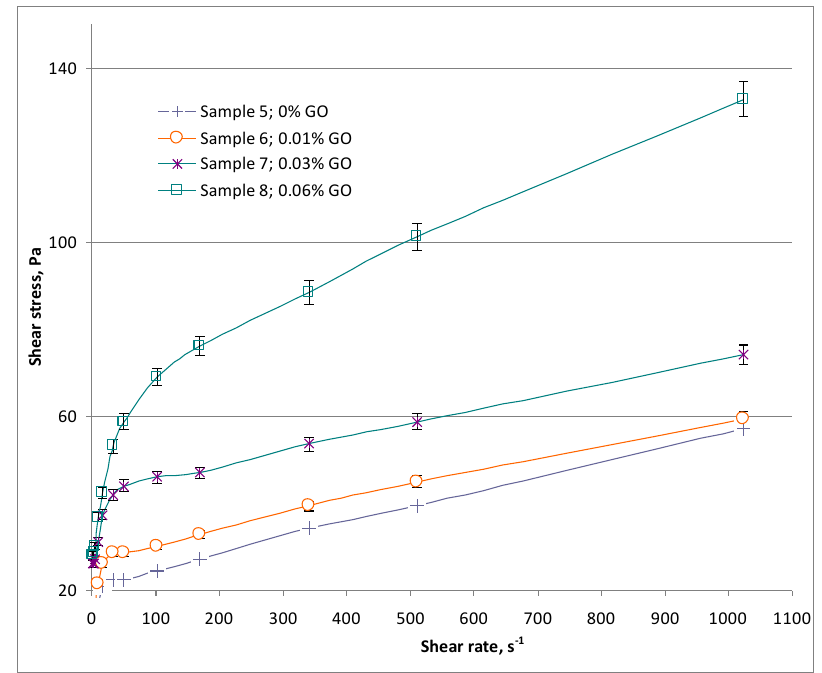
Figure 3. Graph of shear stress dependence on shear rate for slurries containing graphene oxide and a latex admixture. Energies 2020 , 13 , x FOR PEER REVIEW